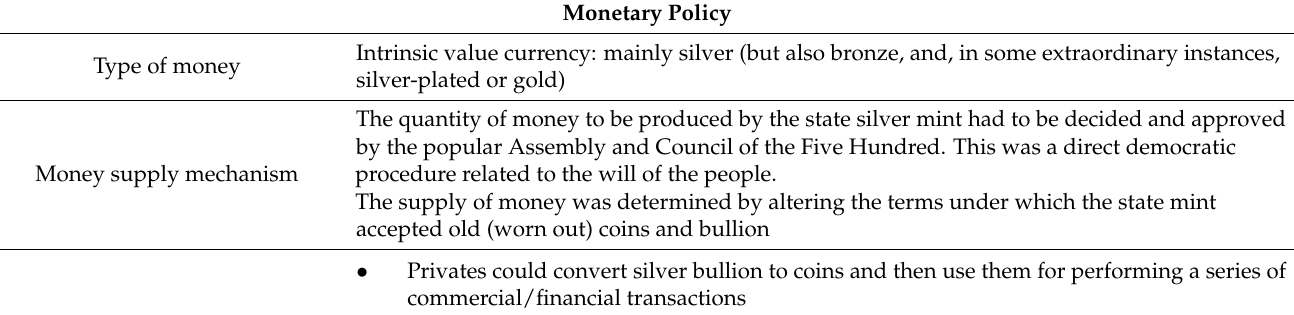
Table 1. The operation of money in the Athenian economy. Monetary